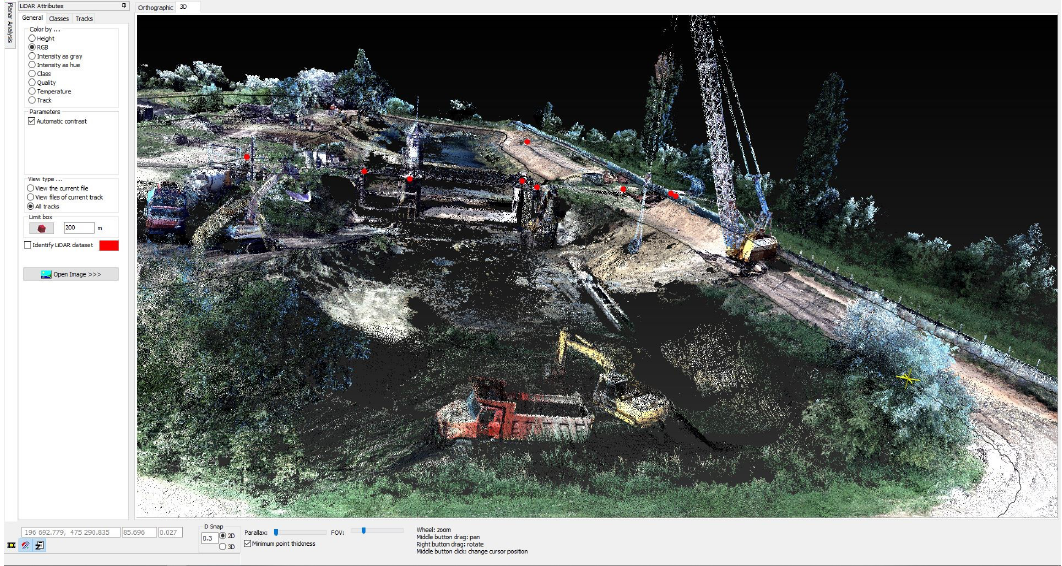
Figure 20. Coloring of the points clouds by the Walks, NH Sânmihaiu Roman. Water 2020 , 12 , x FOR PEER REVIEW